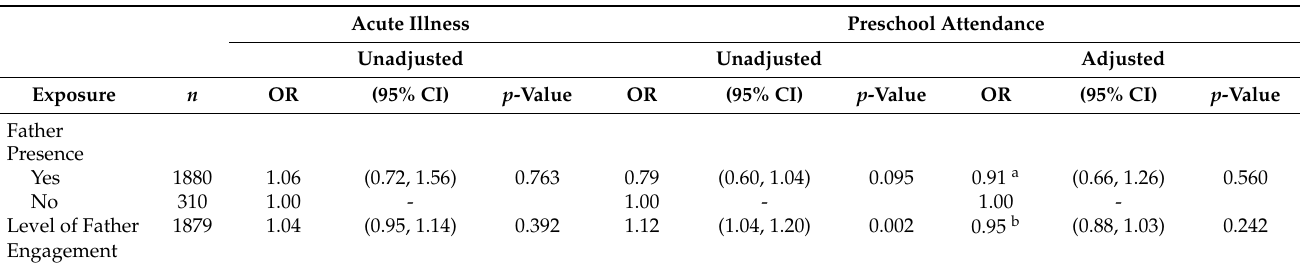
Table 2. Odds ratio estimates from the unadjusted and adjusted analyses of the association between the father’s role and child